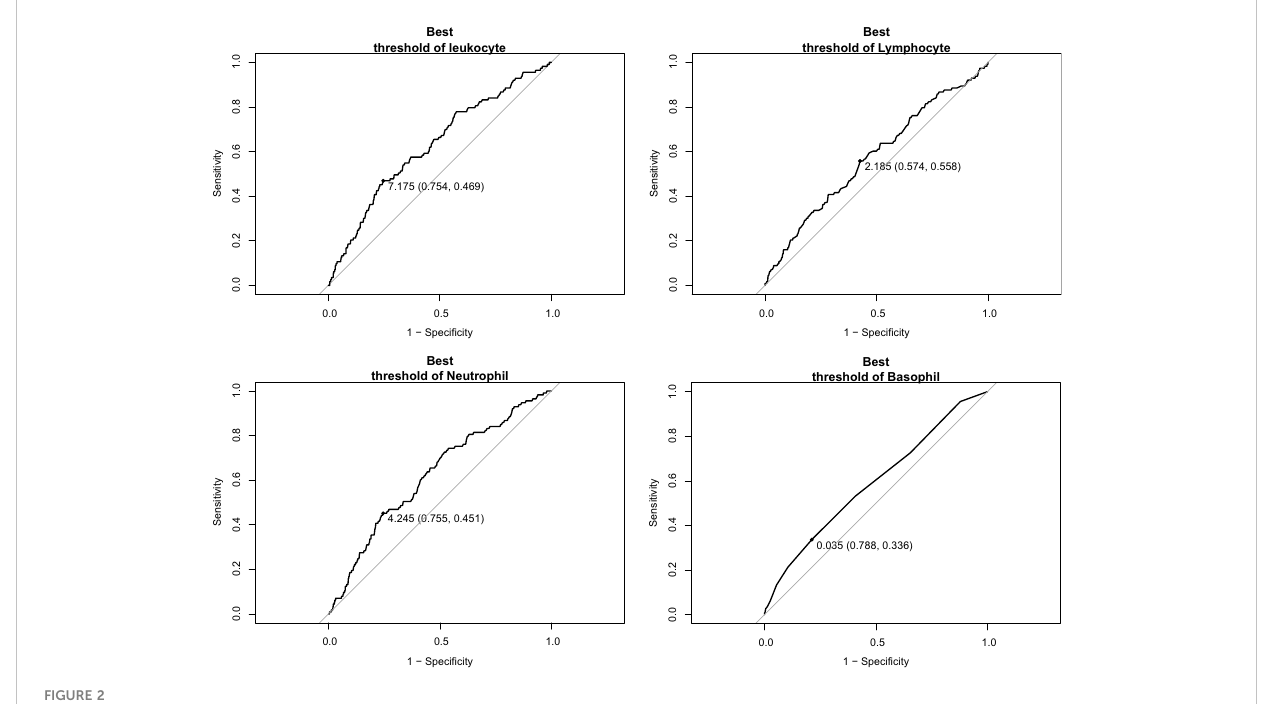
FIGURE 2 ROC curves and best thresholds for leukocyte, lymphocyte, neutrophil, and